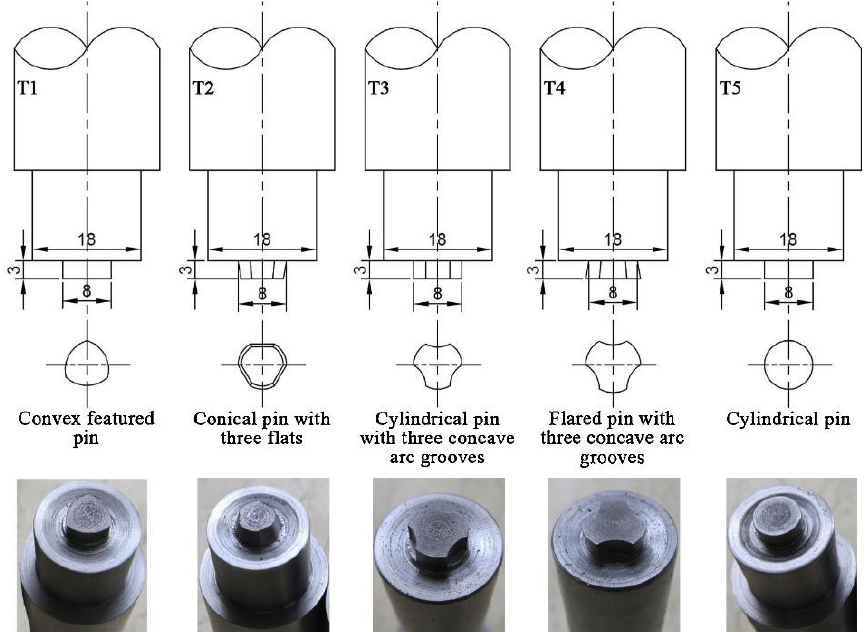
Figure 9. Different types of tool pin profile used to produce high quality Al-li 2195 build (reprinted from [62] with permission from Elsevier).